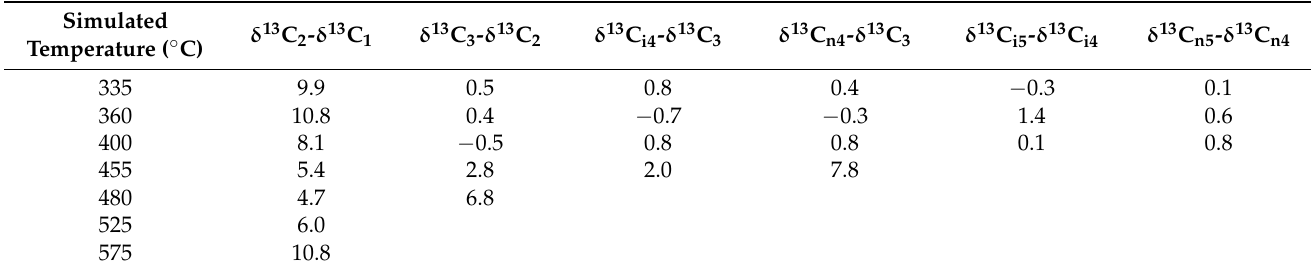
Table 3. The variation in the values of δ 13 C n – δ 13 C n − 1 ( n ≥ 2) with increasing Ro.